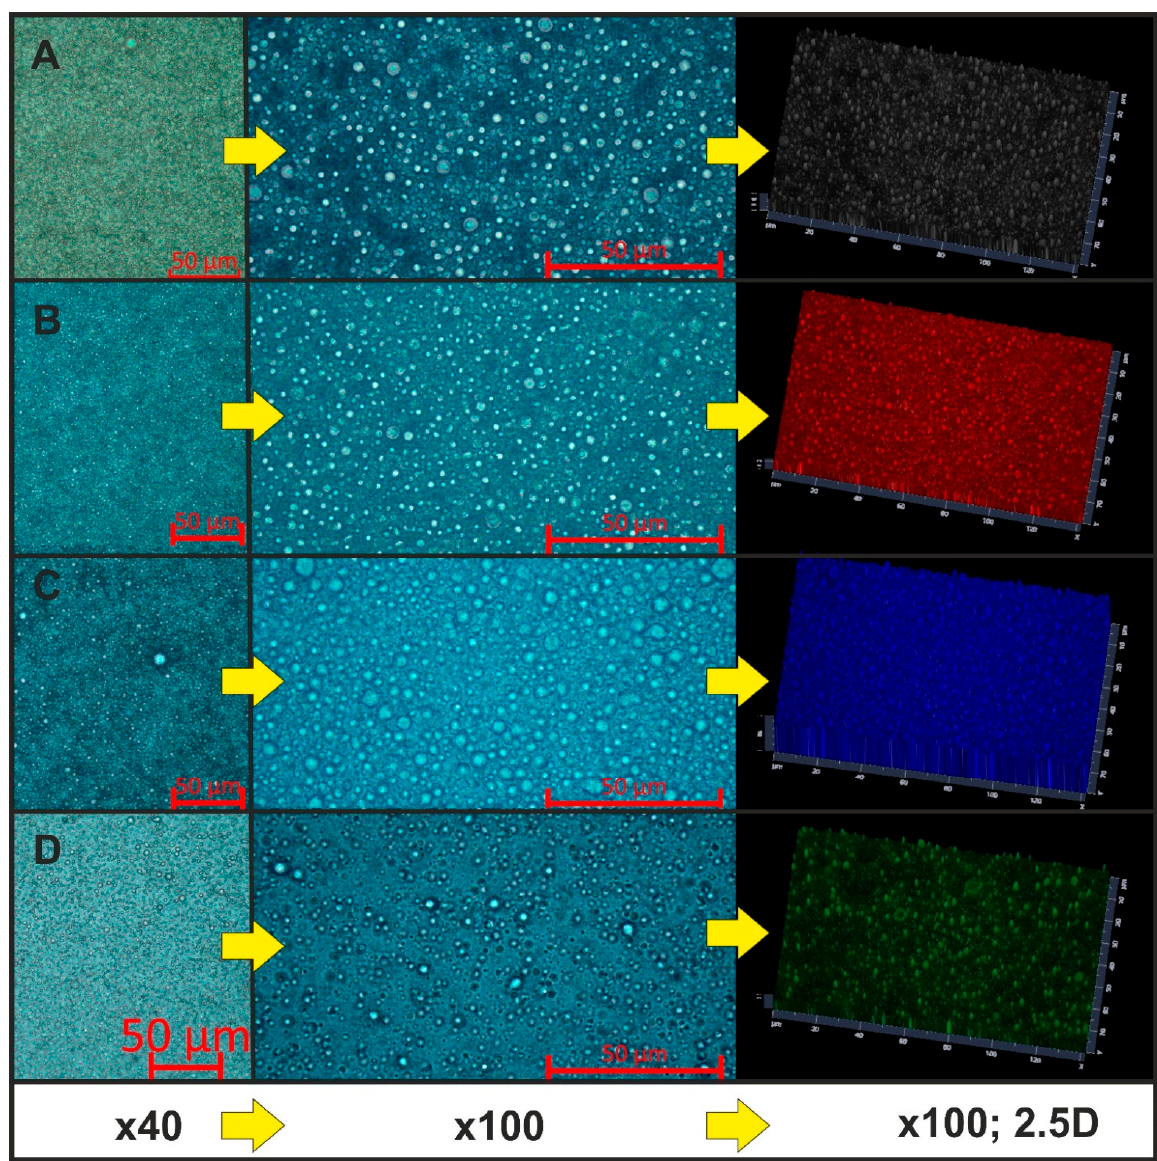
Figure 3. Microscopic images of the emulsion droplets (magnification, ×40, ×100, and ×100; 2.5D image): ( A ) S02, ( B ) S08, ( C ) S13, ( D ) S14 (the images were adjusted as the best fit and colored with software).